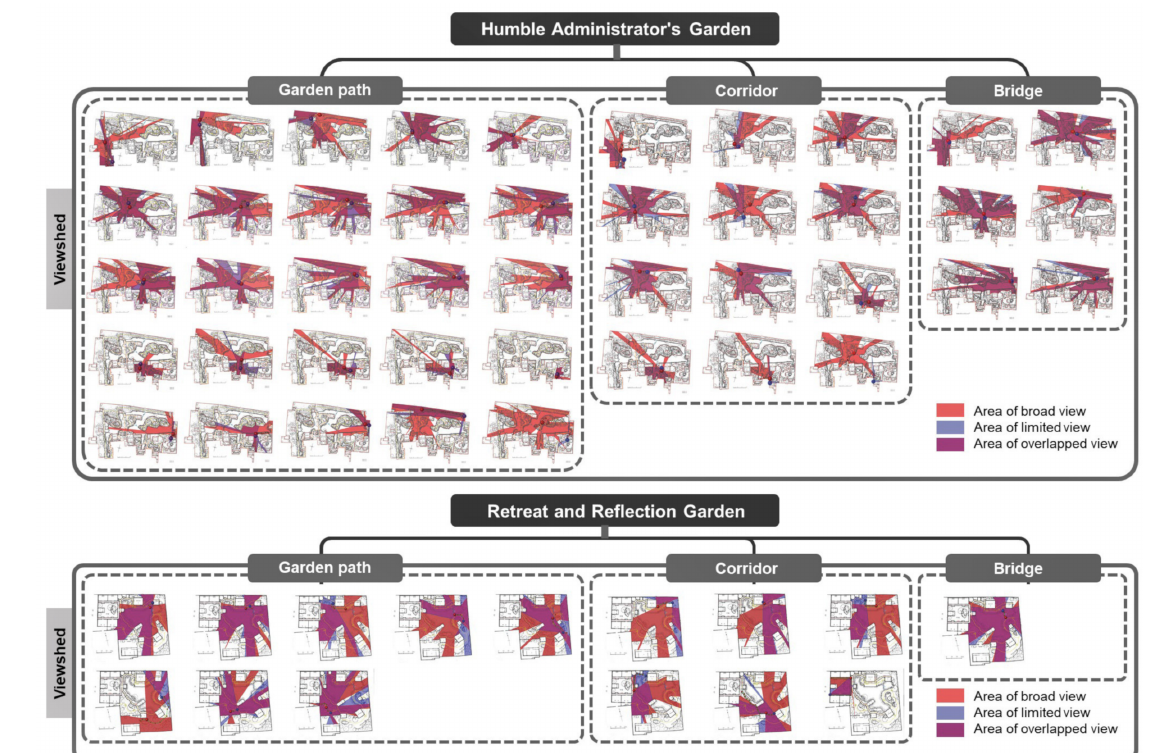
Figure 7. Road viewshed area analysis.